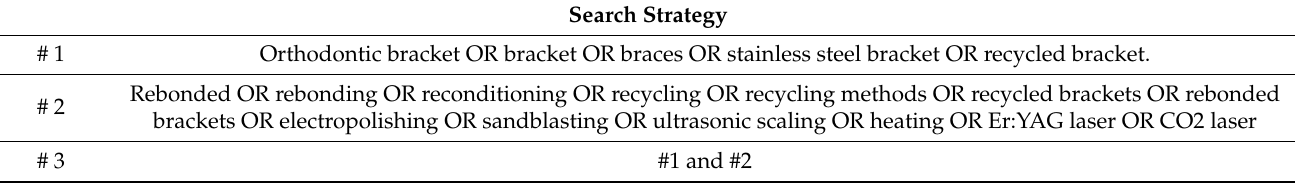
Table 1. Keywords used in the search strategy. Search